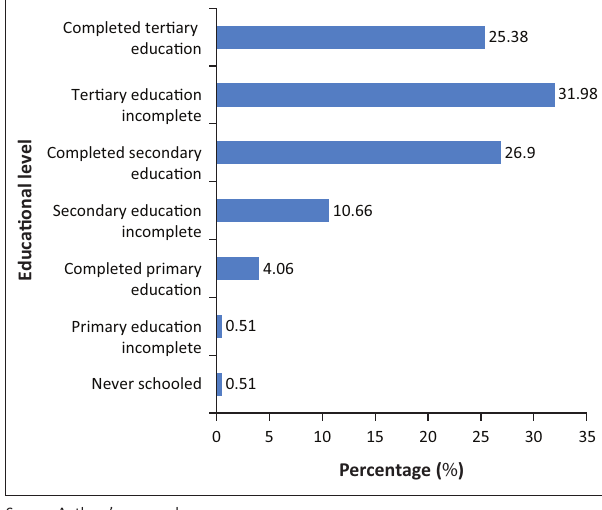
FIGURE 1: Participants’ age.